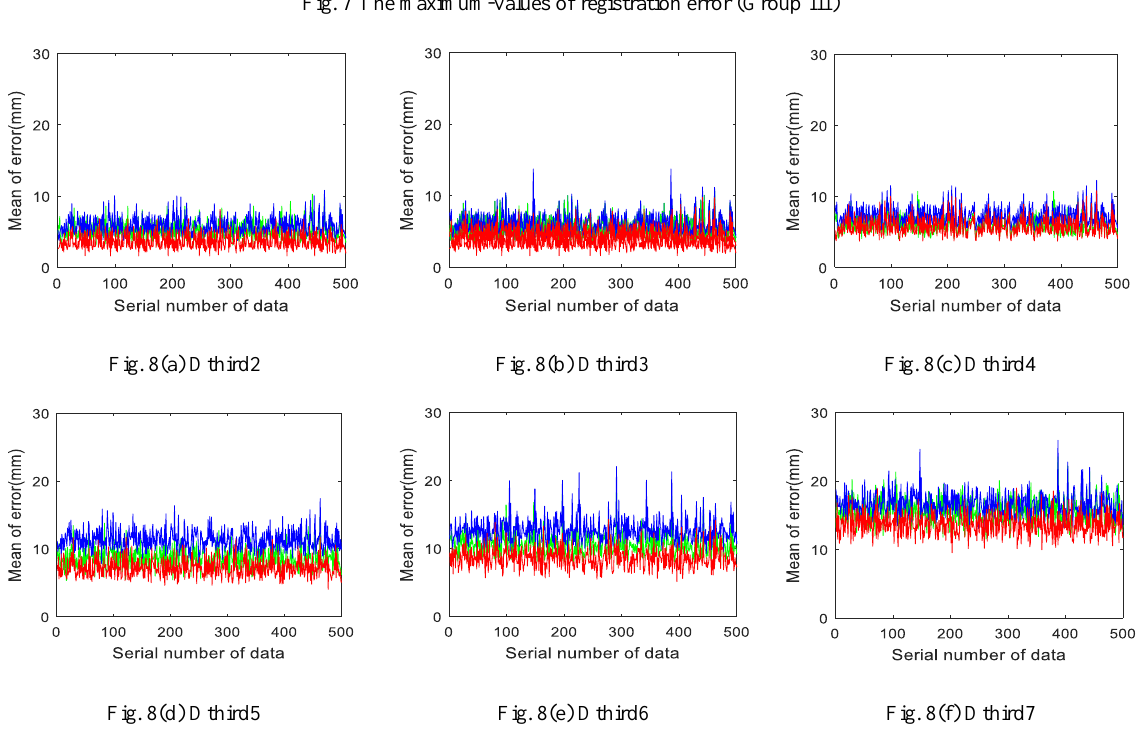
Fig. 7 The maximum-values of registration error (Group III)